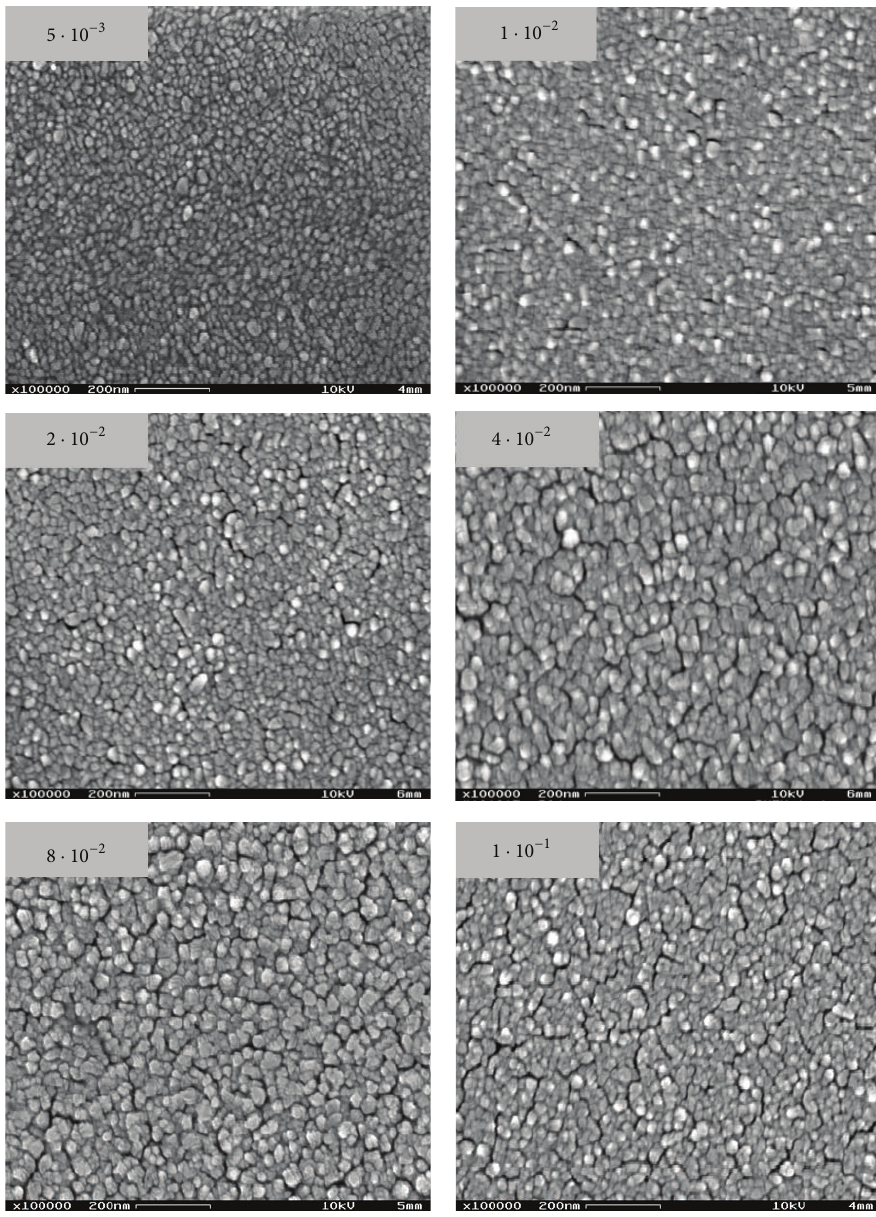
Figure 2: SEM images of as-deposited Pd layers at different sputtering